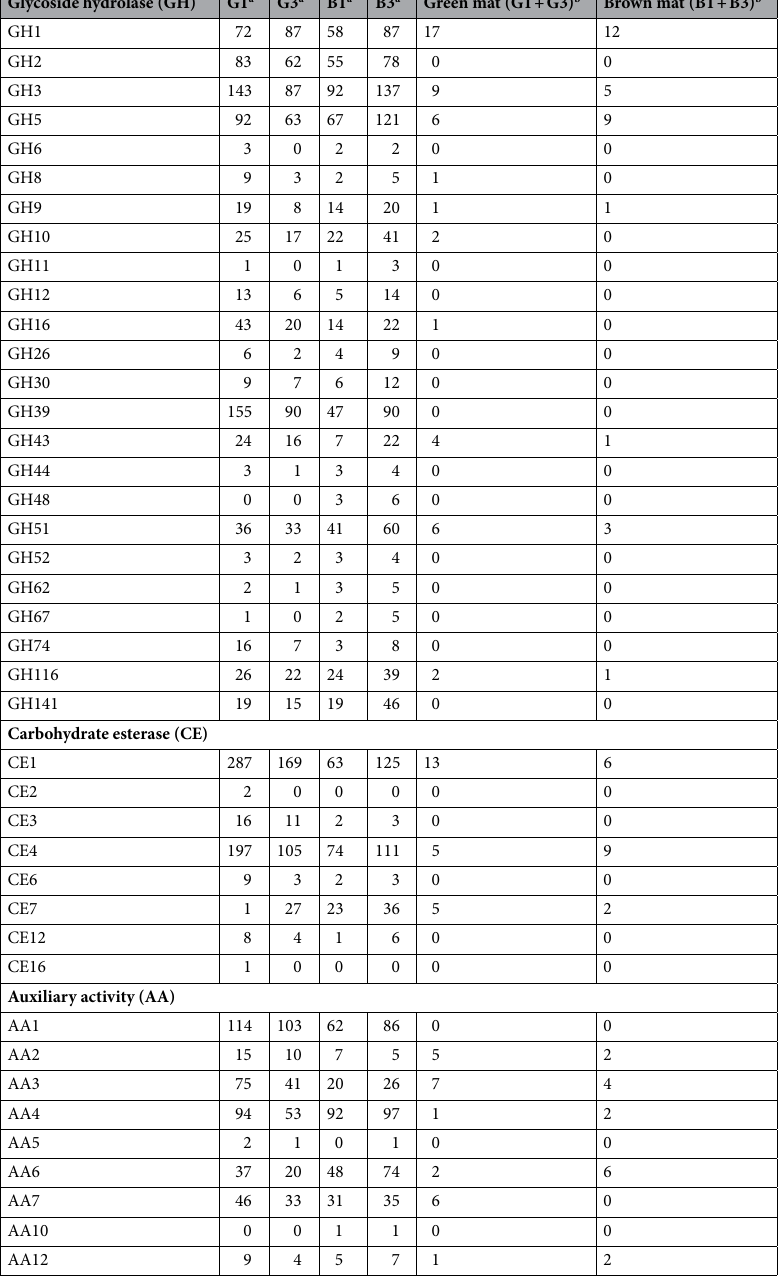
Table 1. Number of sequences associated with GH, CE, and AA families that were putatively associated with lignocellulosic hydrolysis and bioconversion. a Blastp subject coverage ≥ 50%, identity ≥ 50%, and amino acid length ≥ 100. b Non-redundant sequences with Blastp subject coverage ≥ 90%, identity ≥ 90%, and amino acid length ≥